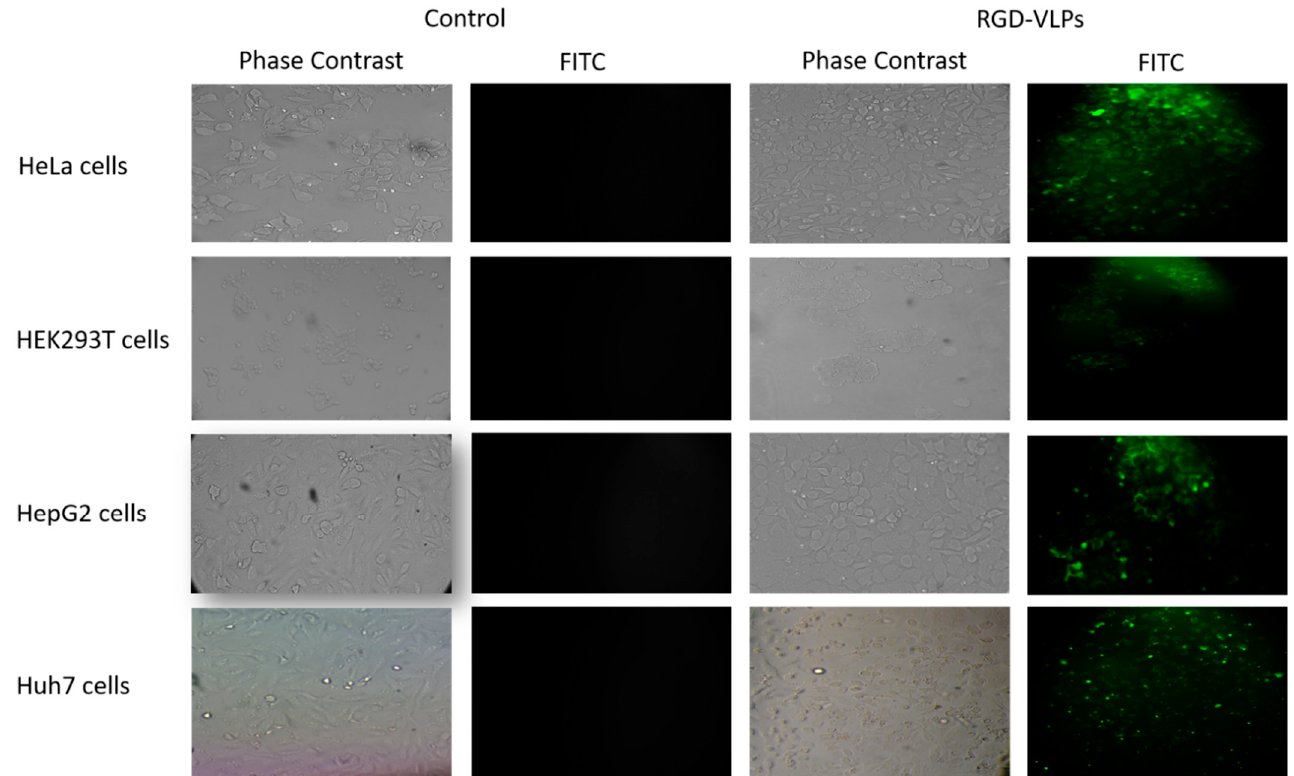
Figure 2. HeLa, HEK-293T, HepG2, and Huh7 cells treated with purified RGD-core protein fused with EGFP at a concentration of 100 µM for 2 h showed a high affinity to tumorigenic cells compared to none or low tumorigenic cells. Controls are cells not incubated with RGD-core.